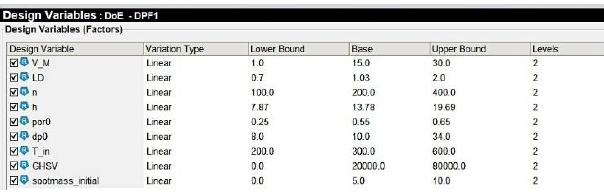
Fig. 6. Input parameters and their value ranges in DoE simulation of PD max.